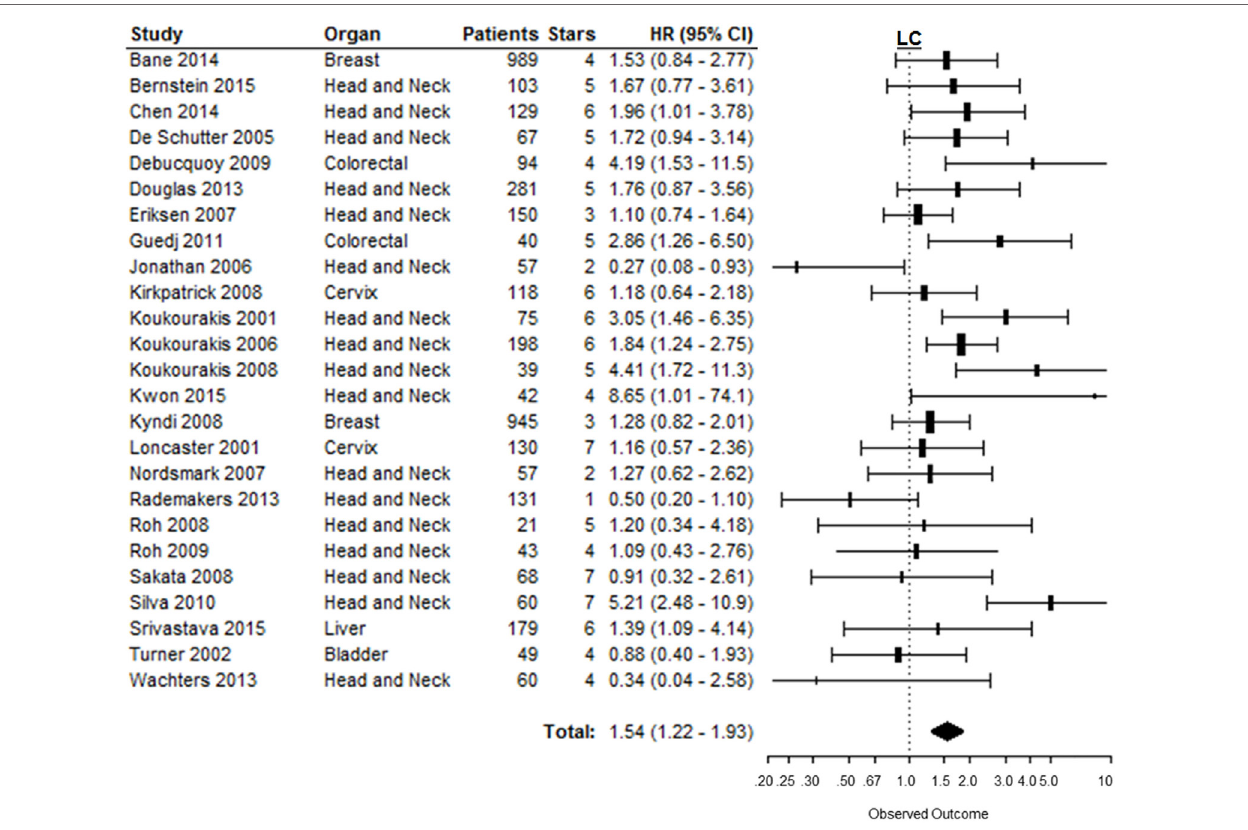
FiGURe 5 | Forest plot of the papers describing the association between CAiX expression and LC . Horizontal bars represent HR with corresponding 95%CI. Symbol size represents the assigned weight of the study. The overall HR with 95%CI is visualized with the diamond shape. Dashed line indicates no association between CAIX and prognosis (24–28, 52, 59, 94, 95, 112, 116, 122, 133,